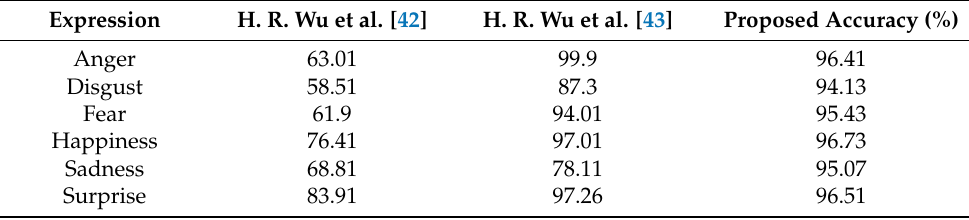
Table 9. Accuracy Comparison for Facial Expression